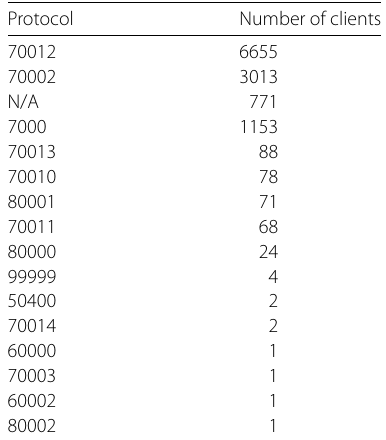
Table 1 Bitcoin Protocol version used by nodes